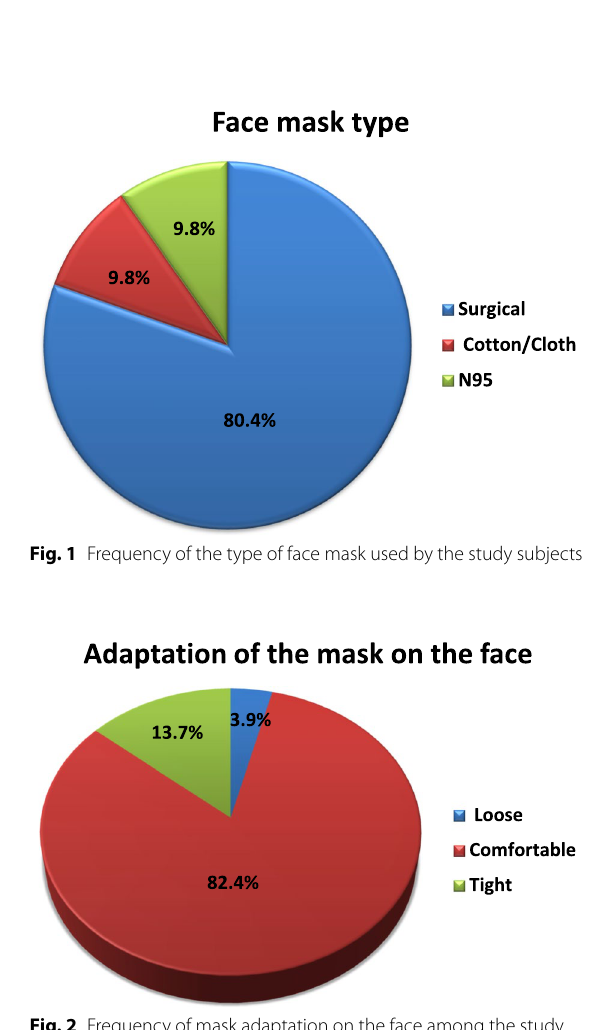
Table 2 Voice demand during work among the study subjects